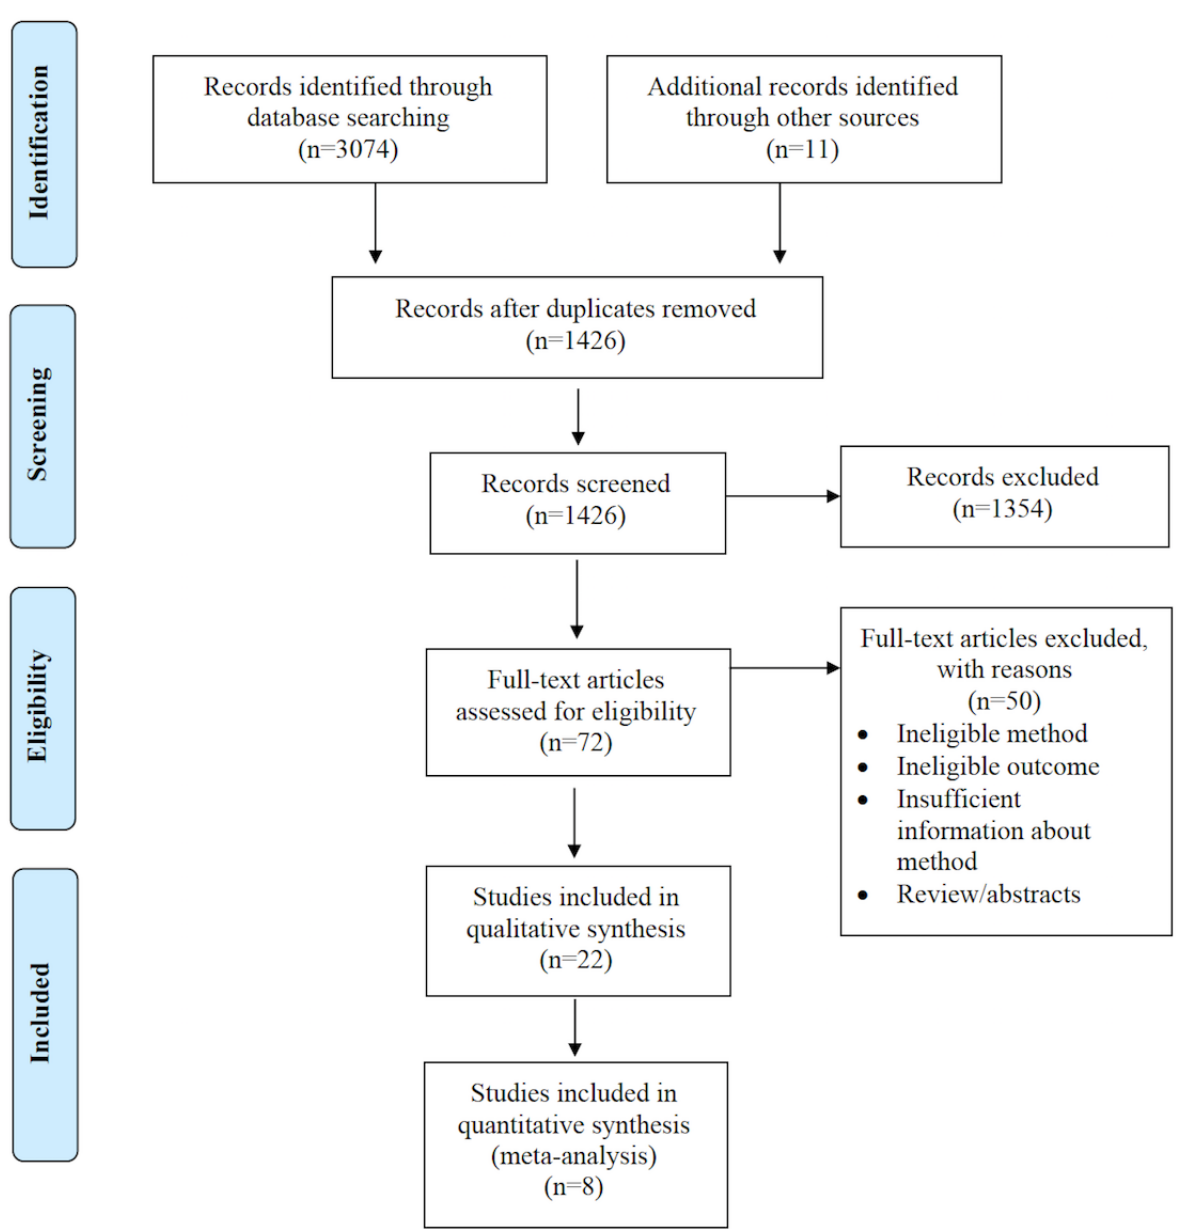
Figure 1. Flow diagram adapted from Moher et al [14] describing the search strategy of databases to retrieve and qualify publications of relevance for